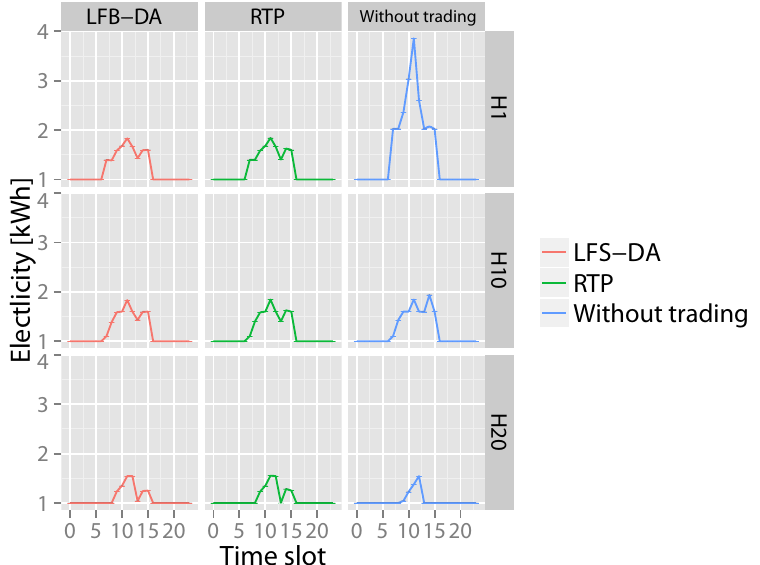
Figure 8. Electricity consumption profile of three